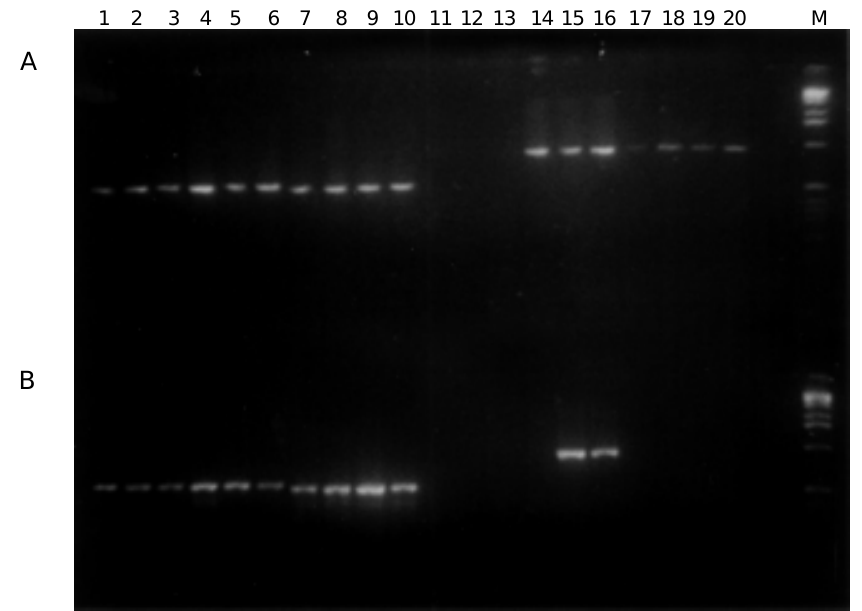
Figure 1 - Agarose gel electro- phoresis of PCR products. The annealing temperature of PCR was 55 o C (A) or 61 o C (B).